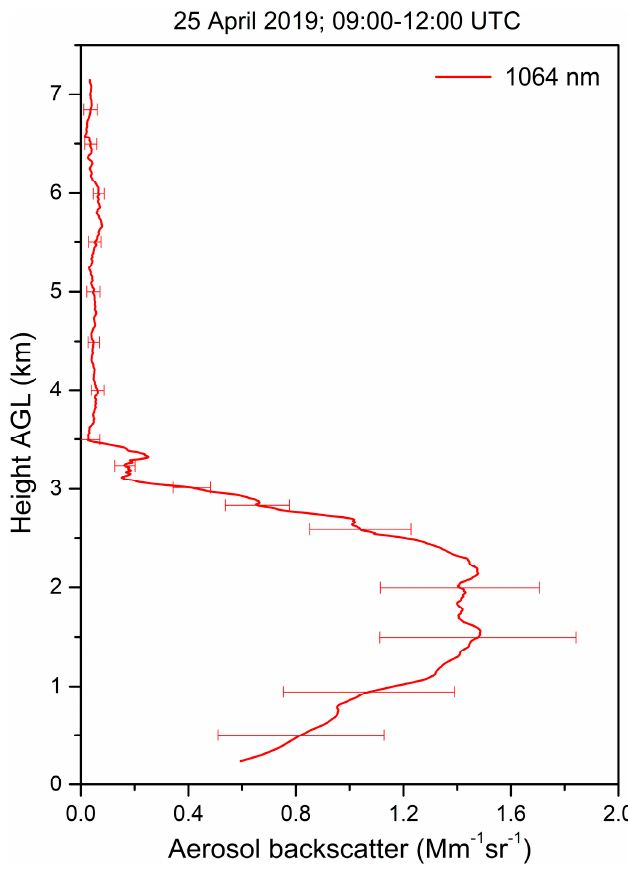
Figure 10. Time-averaged vertical profile of the aerosol BSC as retrieved from the daytime lidar measurements performed on 25 April 2019.